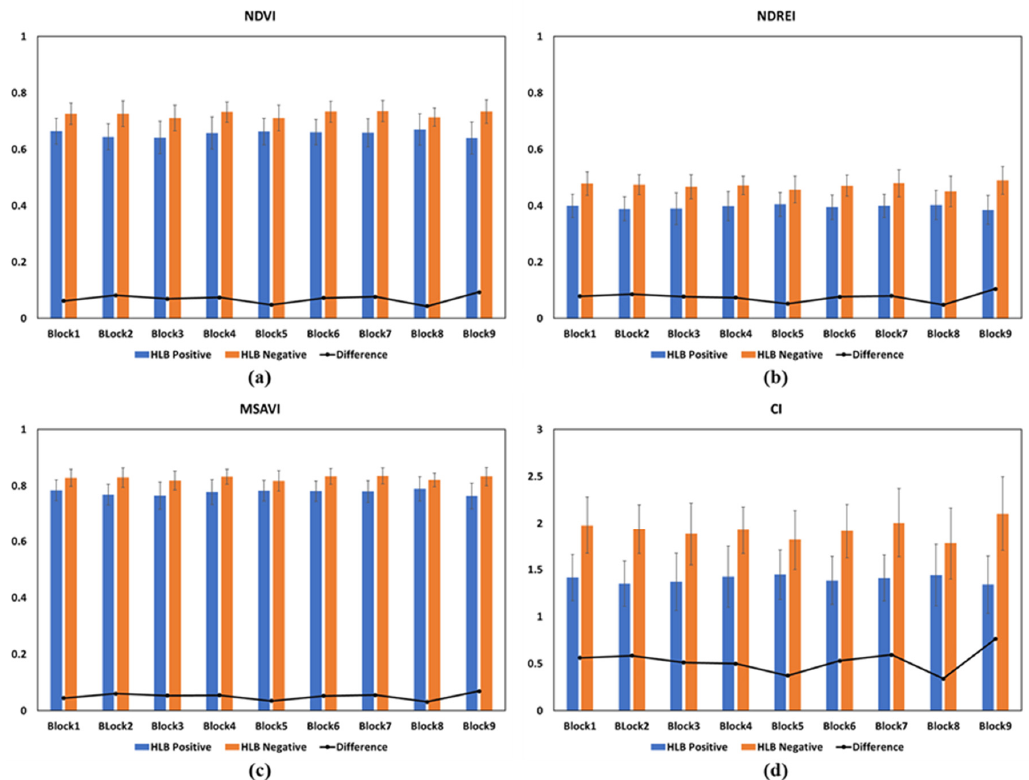
Figure 6. Average of and differences in VI values between the citrus greening positive and negative trees for ( a ) NDVI, ( b ) NDRE, ( c ) MSAVI, and ( d ) CI. Error bars show ( ± ) one standard deviation of the observations.